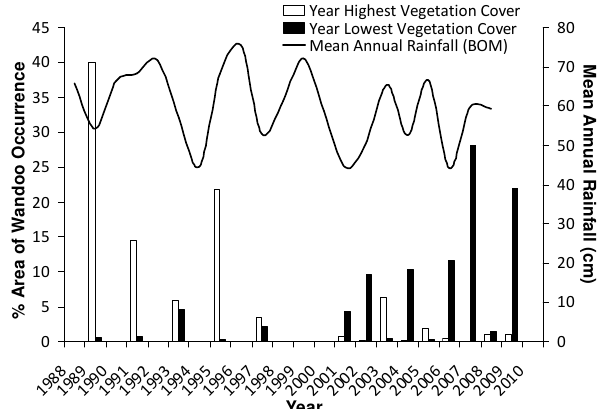
Figure 2. Bar graph showing percentage of wandoo occurrence area for each year in the image sequence with the highest and lowest cover. Line graph shows mean annual rainfall across wandoo occurrence from interpolated rainfall data (Bureau of Meterology Australia).